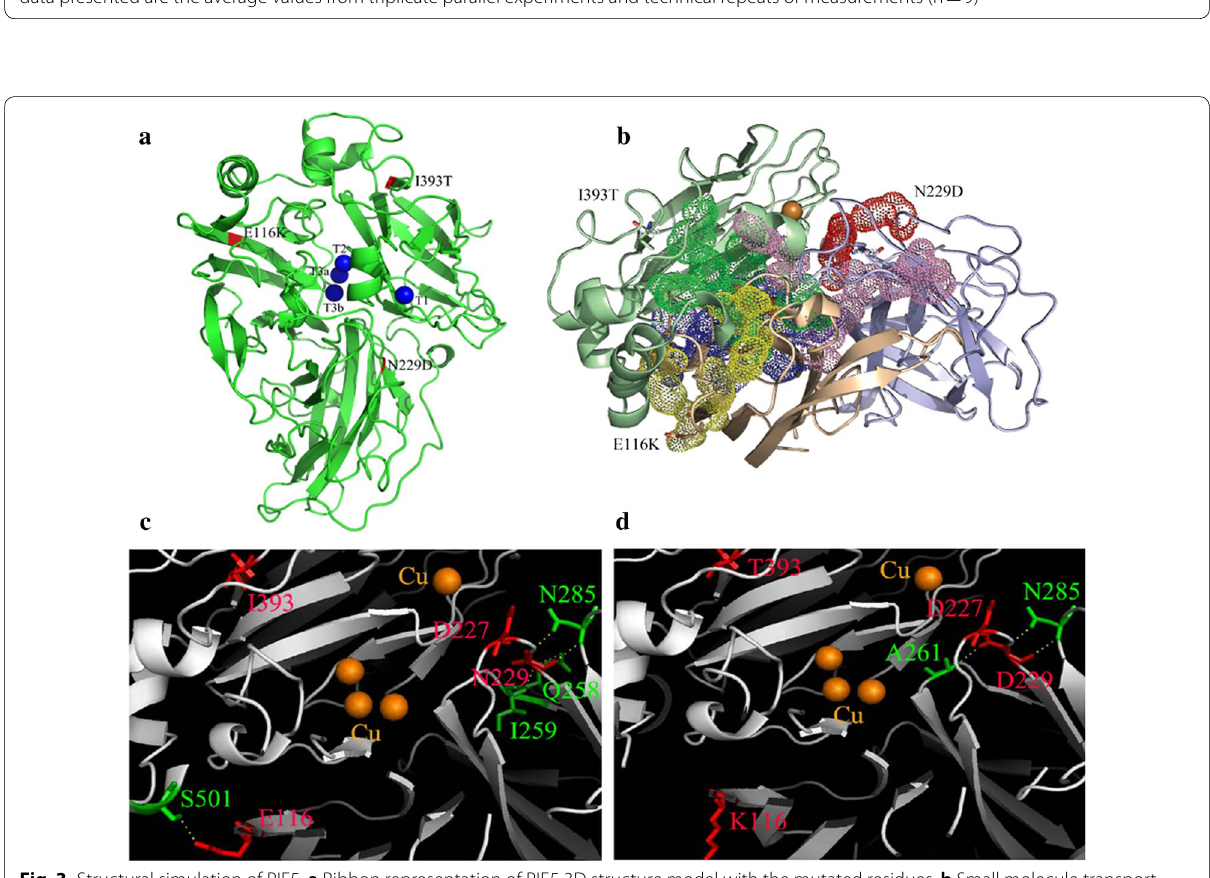
Fig. 3 Structural simulation of PIE5. a Ribbon representation of PIE5 3D structure model with the mutated residues. b Small molecule transport channels in PIE5. Green: channel p1; Red: channel p2; Pink: channel p3; Blue: channel p4; Yellow: channel p5. c , d Stereo views of the local sites in C. cinerea rLcc9 ( c ) and the mutated sites in variant PIE5 ( d